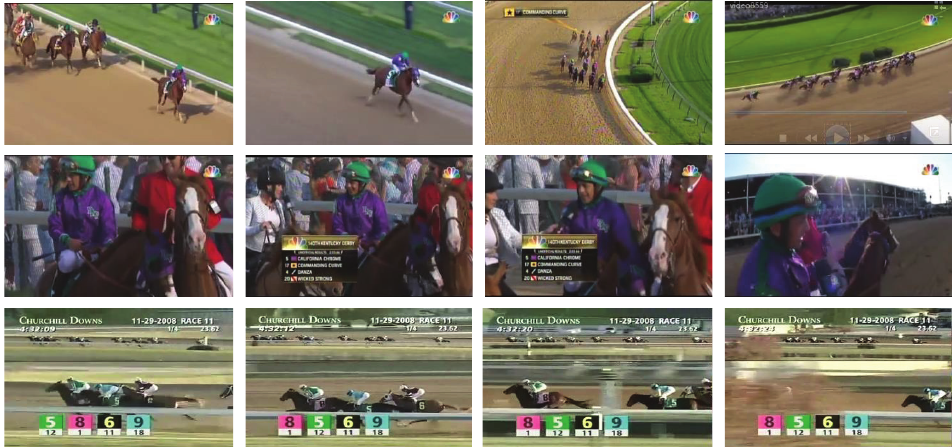
Figure 8. Top 3 text-to-video retrieval examples on the MSR-VTT test